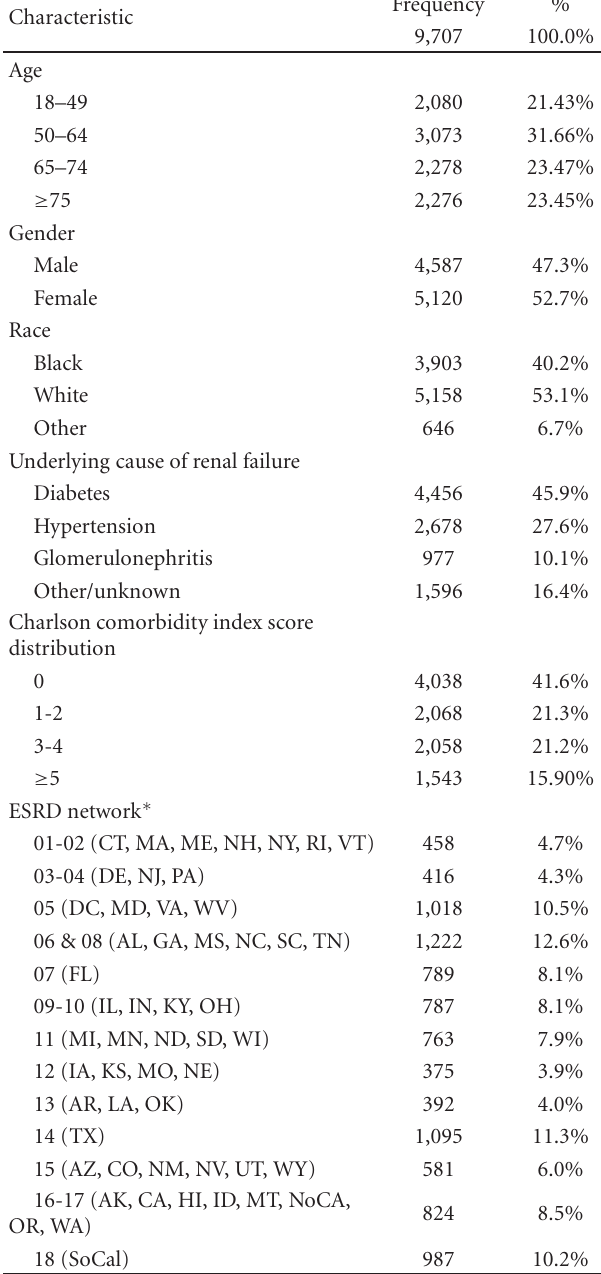
Table 1: Demographic and clinical characteristics of the study